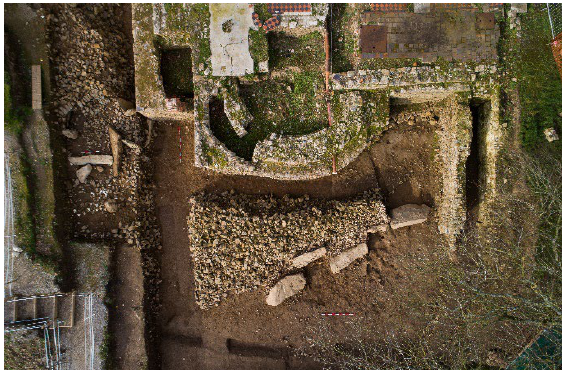
Figure 5. An aerial view showing the 18 th century basement and the later 19 th century extension and tunnel, with the partially exposed southern chamber to the west and exposed kerb and cairn remains to the south. ©Ken Williams While both chambers are located in the western half of the cairn, one to the north and one to the south, they are morphologically distinct, with the northern chamber assuming a stalled configuration and its southern counterpart seemingly comprising a sub-circular arrangement, with at least one side chamber opening to the east. No upstanding evidence of corresponding passageways has yet been identified. However, disturbed megaliths in the vicinity of the northern chamber may represent the remains of an associated passage. Megalithic art has been identified in both chambers and on the kerb, the exposed remains of which comprises six kerbstones, five of which are contiguous. Kerbstone 2 (K2), which has slipped forward and is now lying in a supine position, is elaborately decorated across much of what was its outward facing surface (Figure 6).